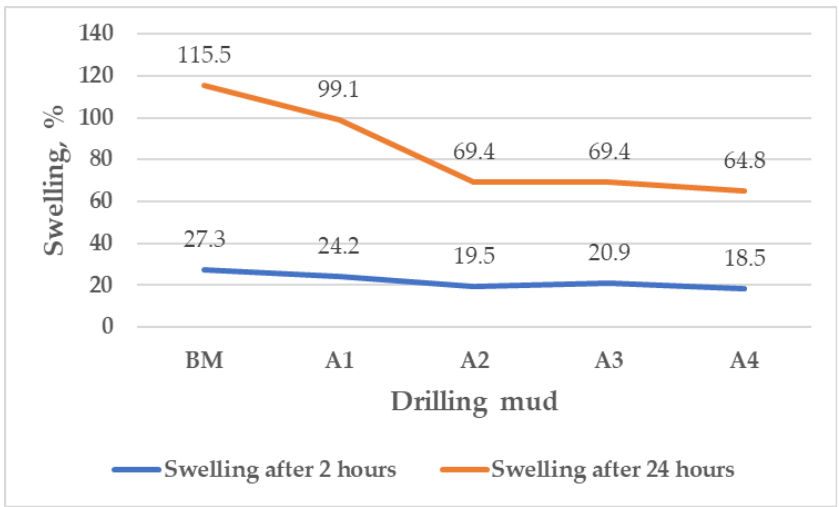
Figure 9. Pellet swelling in base mud and in mud with added MPP (particles less than 0.1 mm) within 2 and 24 h at 90 °C.